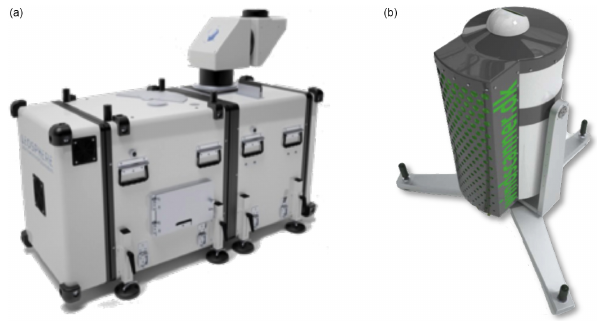
Figure 1. DTU Wind Energy scanning lidars. Long-range Wind- Scanner (a) ; short-range WindScanner (b)